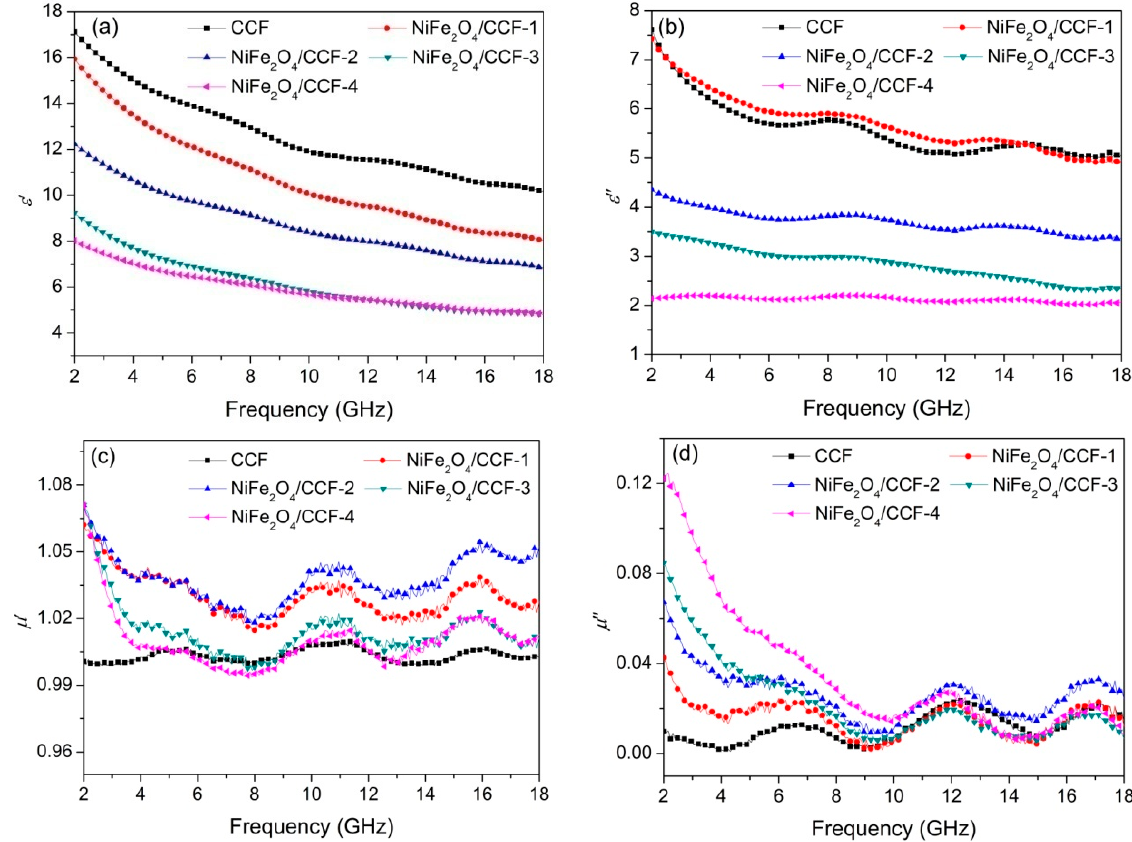
Figure 6. Frequency dependence of ( a ) ε ’, ( b ) ε ″ , ( c ) μ ′ , and ( d ) μ ″ for CCF, NiFe 2 O 4 /CCF-1, NiFe 2 O 4 /CCF-2, NiFe 2 O 4 /CCF-3, and NiFe 2 O 4 /CCF-4.